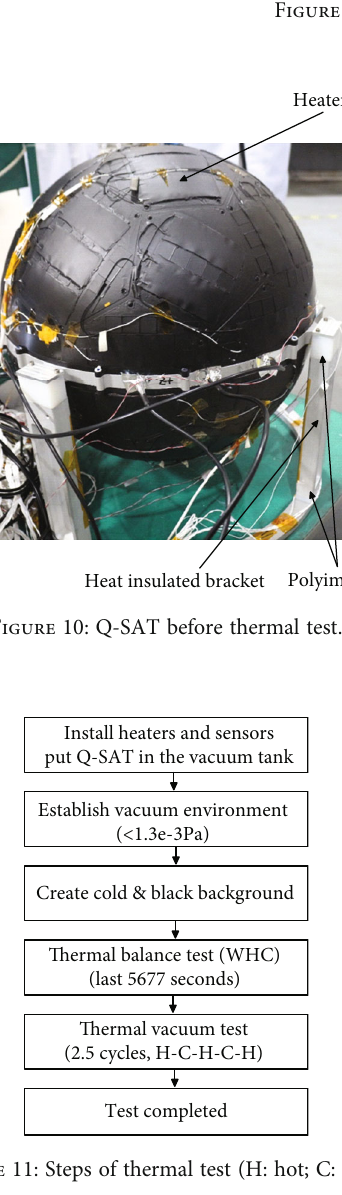
Figure 9: The layout of the distributed heaters.